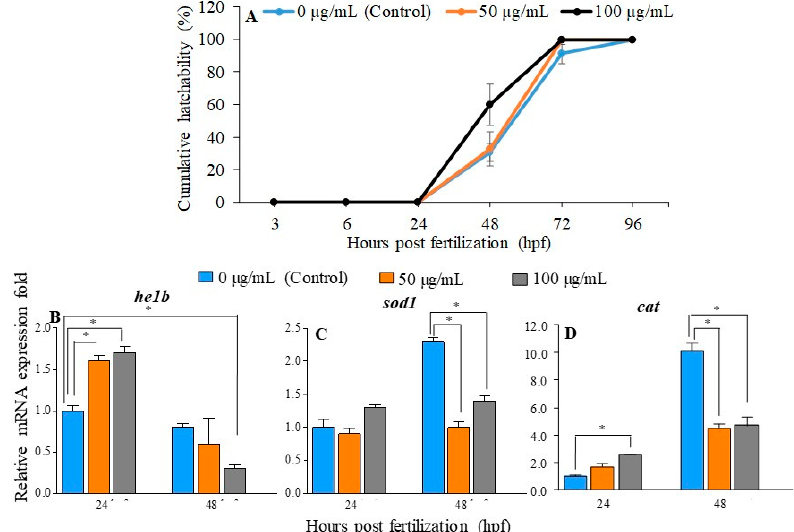
Figure 1. Solubility and effect of purified porcine gastric mucin (PGM) on the zebrafish embryos’ toxicity. ( A ) Type III PGM stock solution (4 mg/mL). ( B ) Mortality of zebrafish embryos exposed to